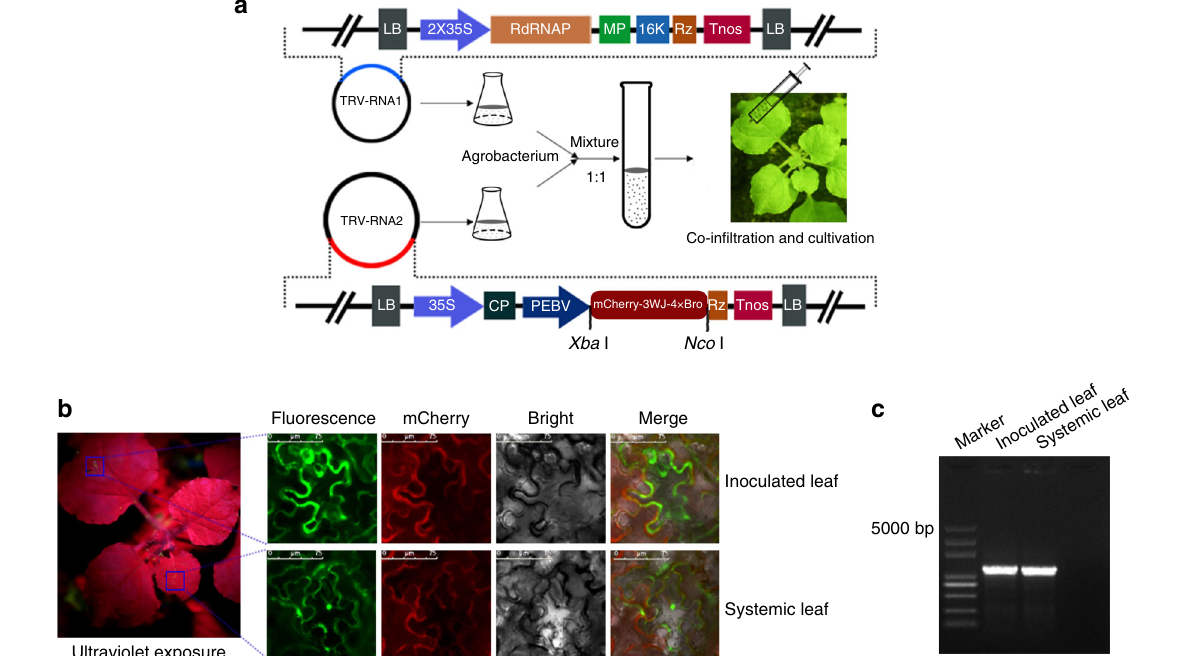
Fig. 6 Detection of long-distance RNA delivery by 3WJ-4× Bro in N. benthamiana . a Schematic diagram of the Agrobacterium binary vector system containing the TRV RNA1 and RNA2 genomes with some modi fi cation, as well as the experimental scheme of the TRV-mediated target RNA delivery. RNA1 contains LB (left border), 2 × 35S (2 × CaMV 35S promoter), RdRNAP (encoding RNA-dependent RNA polymerase), MP (encoding movement protein), 16k (encoding a cysteine-rich protein), Rz (self-cleaving ribozyme), Tnos (nopaline synthase terminator), and RB (right border). RNA2 contains LB, p35S, CP (encoding coat protein), PEBV (pea early browning virus promoter), Rz, Tnos, and RB. mCherry - 3WJ-4 × Bro was cloned under the control of PEBV. The fl ask, tube, and syringe are drawn by software Photoshop CS6. b Fluorescence signals of N. benthamiana leaves under ultraviolet and confocal microscopes. Agrobacterium cultures carrying the engineered TRV RNA2 and RNA2 vectors were co-in fi ltrated into N. benthamiana leaves to express and transmit 3WJ- 4 × Bro-tagged RNA ( mCherry - 3WJ-4 × Bro ). At 5 days after Agrobacterium infection, both in fi ltrated and systemic leaves were sampled and then incubated with 10- μ M DFHBI-1T at room temperature for 20 min. Scale bars, 75 μ m. Three independent trials showed the same results. c Con fi rmation by RT-PCR of the presence of the fusion RNA ( mCherry - 3WJ-4 × Bro ) in both in fi ltrated and systemic leaves. Source Data underlying b are provided as a Source Data fi (Table 2). Furthermore, RT-PCR analysis of all the T 2 plants identi fi ed the 572 fl uorescent plants as positive and the 194 non fl uorescent plants as negative (Table 2). These results indicated that 3WJ-4 × Bro linked with the target gene was stably heritable in the transgenic progeny, making 3WJ-4 × Bro an applicable gene marker for plant genetic engineering.